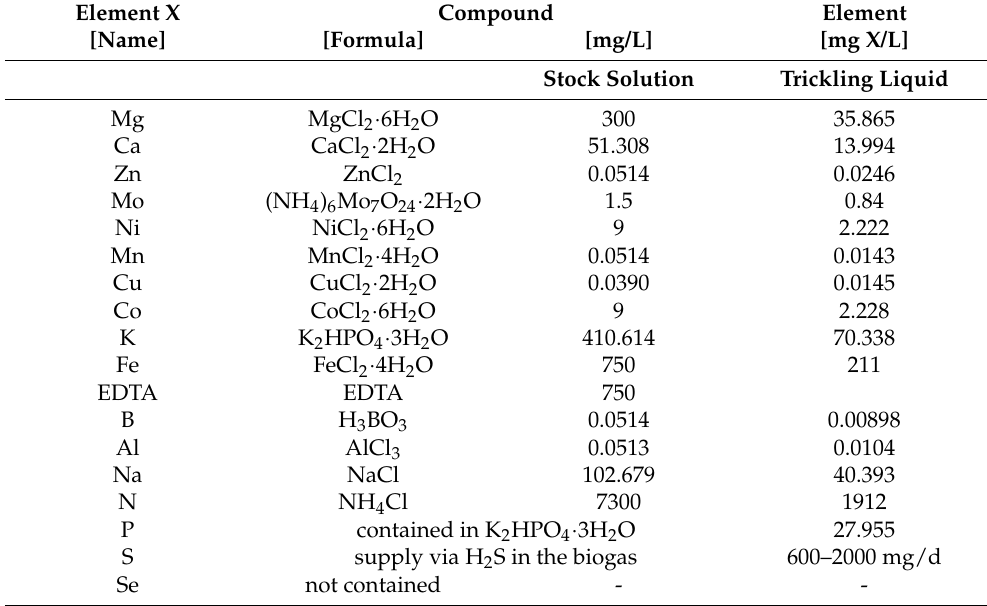
Table 3. Element and compound concentrations in the stock solution used for dosing and the resulting concentration in the trickling liquid.